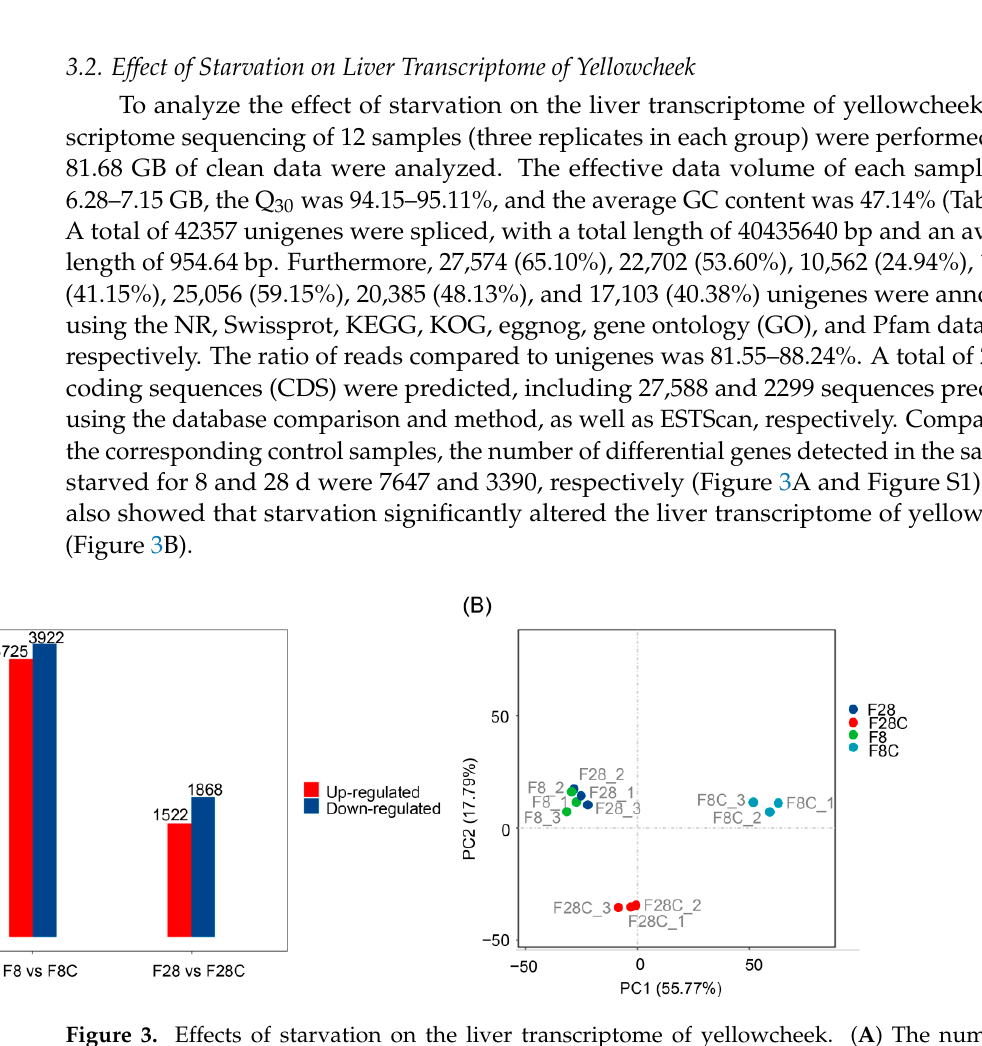
Figure 3. Effects of starvation on the liver transcriptome of yellowcheek. ( A ) The number of significantly upregulated and downregulated genes after 8 and 28 d of starvation. ( B ) Principal component analysis profile showing the differences in the liver transcriptome of yellowcheek with or without starvation. F8C: un-starved yellowcheek samples collected on the 8th day after the starvation experiment; F28C: un-starved yellowcheek samples collected on the 28th day after the starvation experiment; F8: starved yellowcheek samples collected on the 8th day after the starvation experiment; F28, starved yellowcheek samples collected on the 28th day after the starvation experiment.